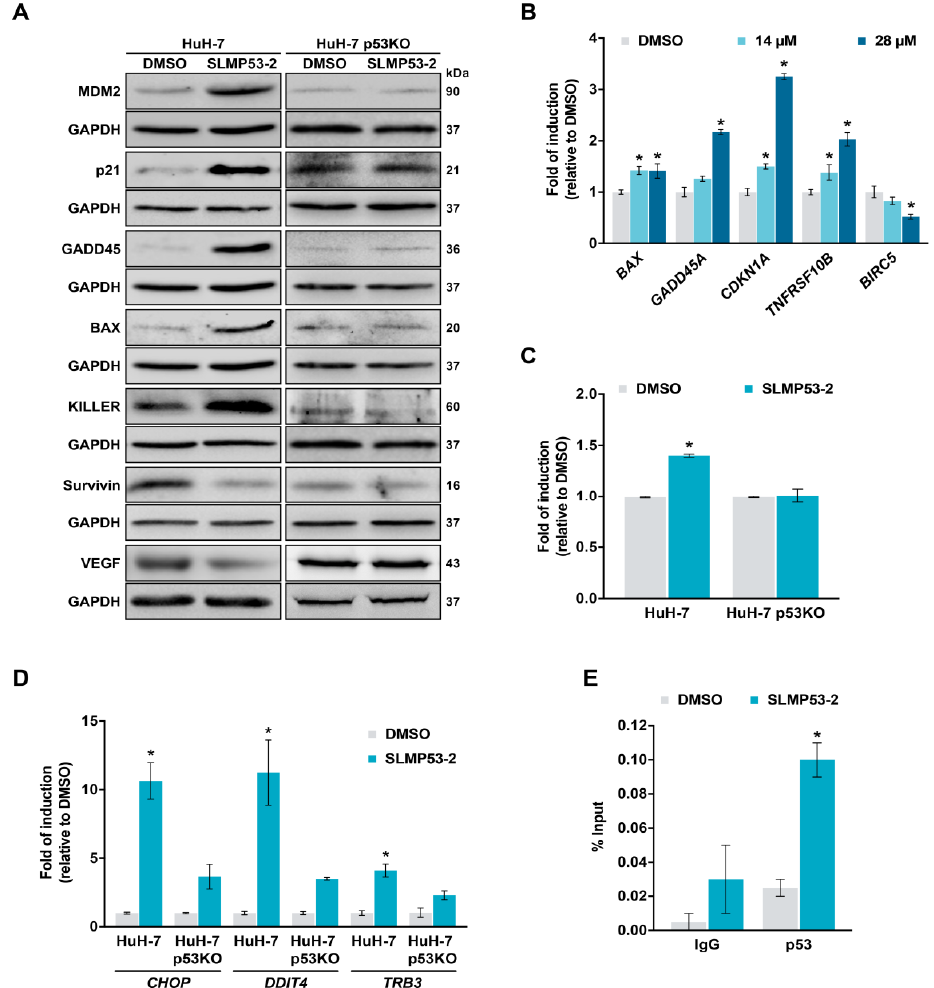
Figure 4. SLMP53-2 induces p53 transcriptional targets, including miR-34a and genes involved in ER stress response, and restores DNA-binding ability to mutp53-Y220C in HCC cells. ( A ) Protein levels of p53 target genes in parental and p53KO HuH-7 cells, after 16 h (p21), 24 h (survivin, VEGF) or 48 h (MDM2, GADD45, BAX, KILLER) treatment with 14 µ M SLMP53-2. Immunoblots represent one of three independent experiments; GAPDH was used as a loading control. ( B ) mRNA levels of p53 target genes, in HuH-7 cells, after 24 h treatment with 14 and 28 µ M SLMP53-2, determined by RT-qPCR;